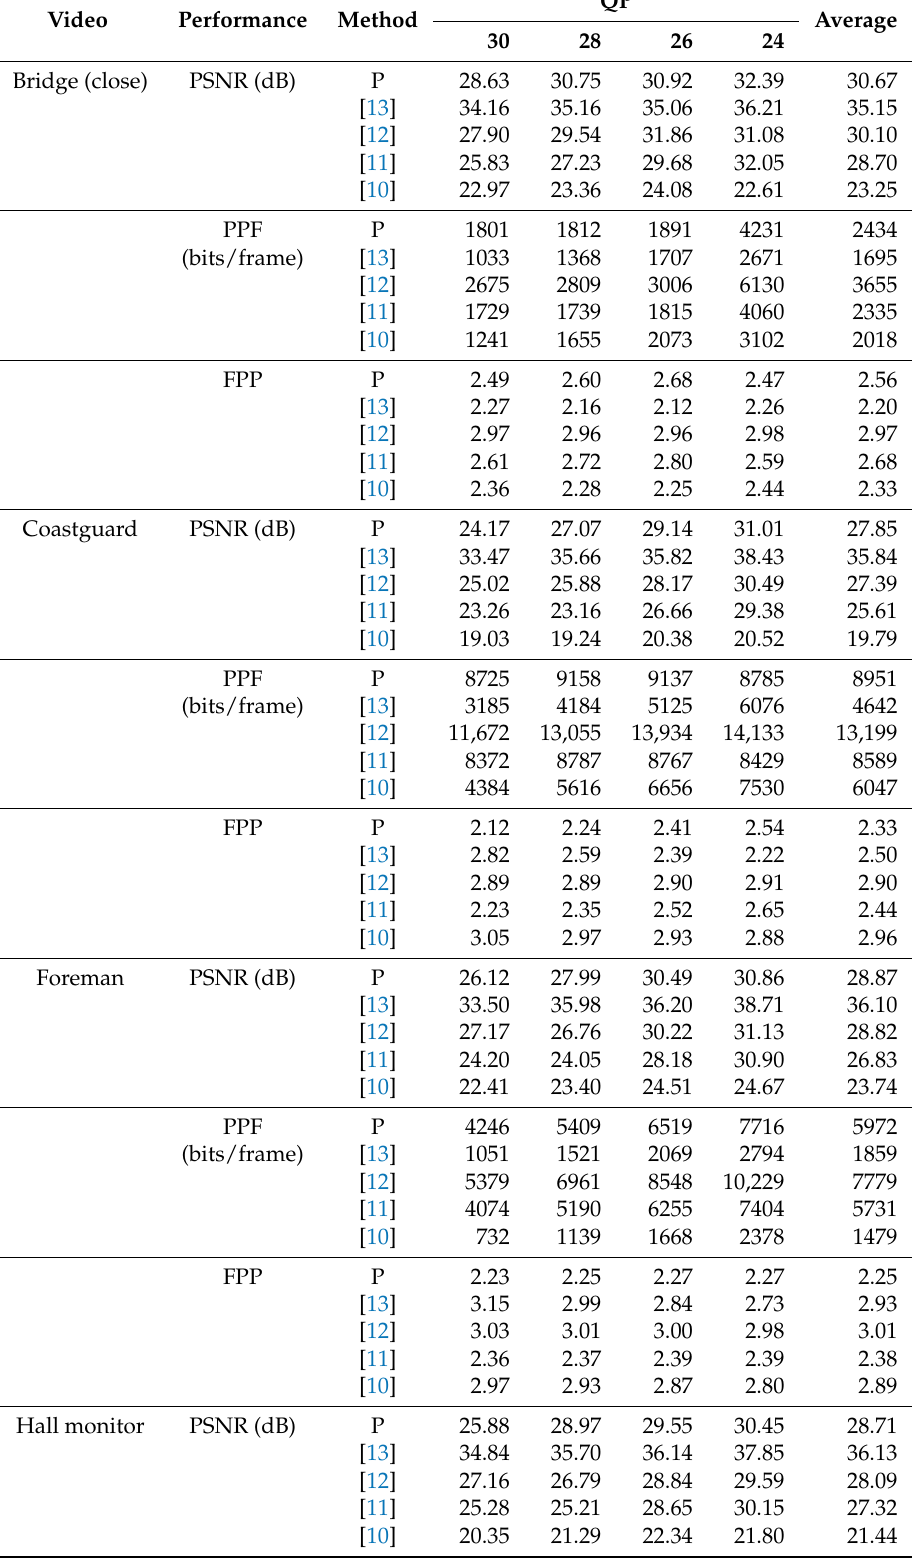
Table 4. Comparison between our proposed method(P) and the methods of [10–13]. Video Performance Bridge (close)